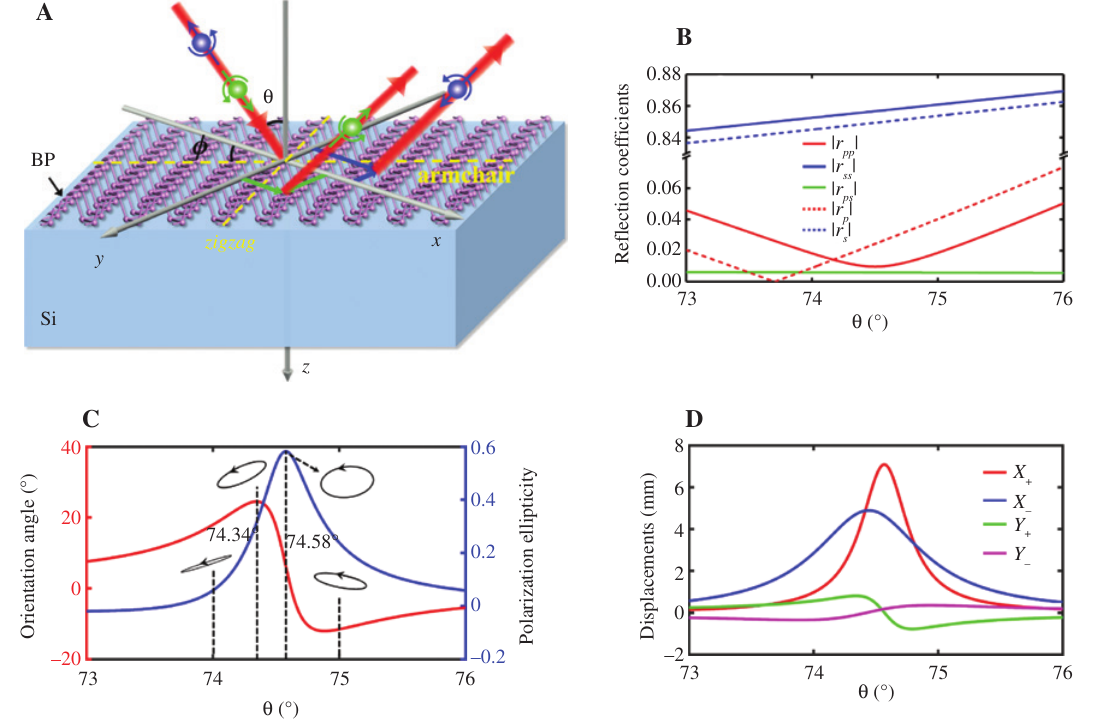
Figure 1: Scheme of BP-Si system, the Fresnel reflection coefficients, orientation angle, polarization ellipticity and Centroid displacements of RCP and